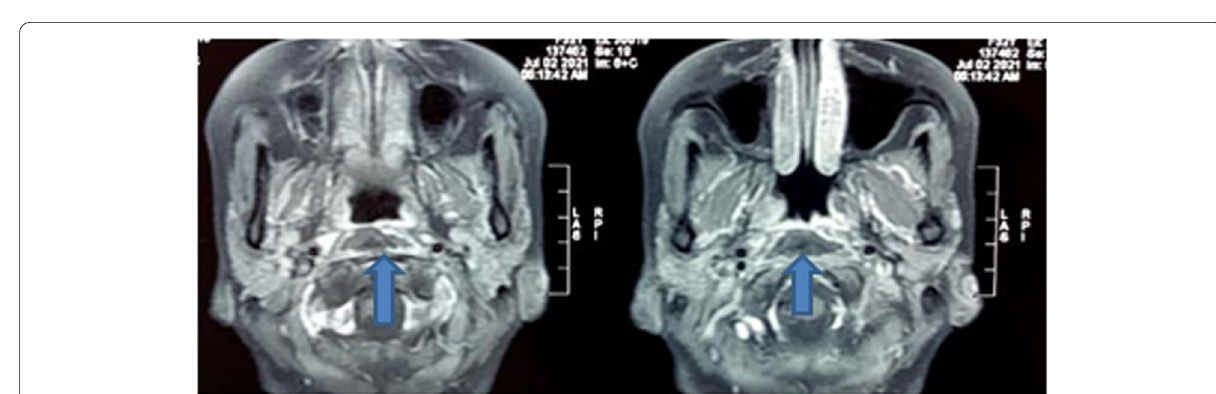
Fig. 2 T1 contrast MRI image (Axial section) showing retropharyngeal abscess with no contrast uptake